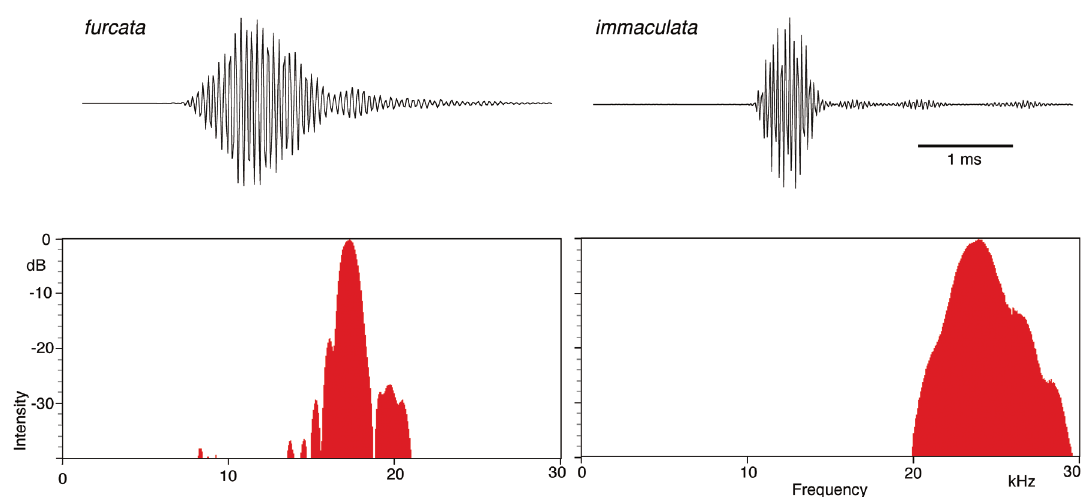
Figure 20. Oscillograms of single syllables of the male calling song and corresponding spectral composition (power spectra).